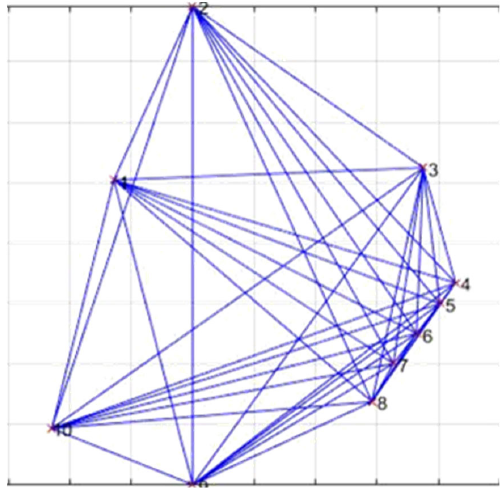
Figure 2 . Network of 10 nodes with all the